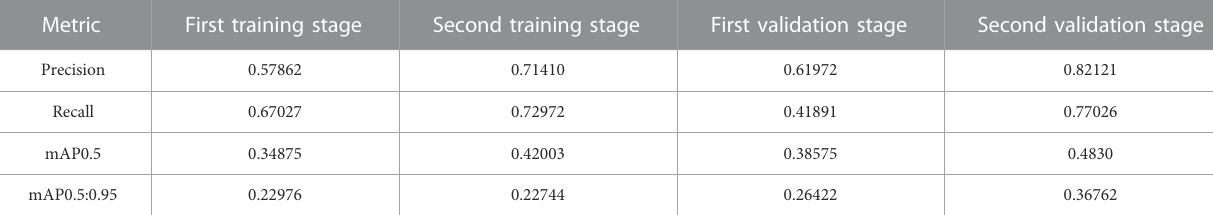
TABLE 1 Model performance for various metrics in both stages, fi rst and